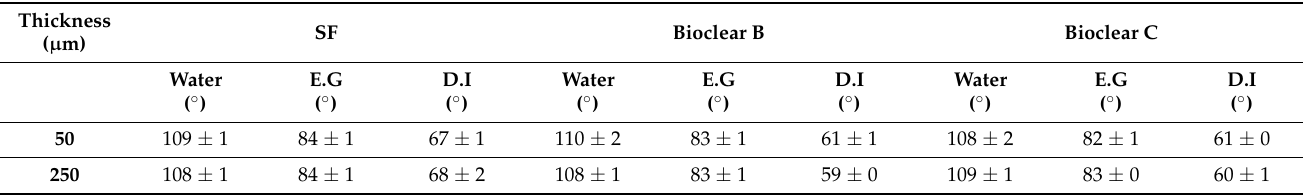
Table A6. CA values of water, ethylene glycol, and diiodomethane on PF-coated soft PDMS sur- faces with different thicknesses. The CA values did not show significant differences with varying thicknesses. Compared to pristine soft PDMS, the values of DI decreased from ~72 ◦ to ~60 ◦ on both Bioclear